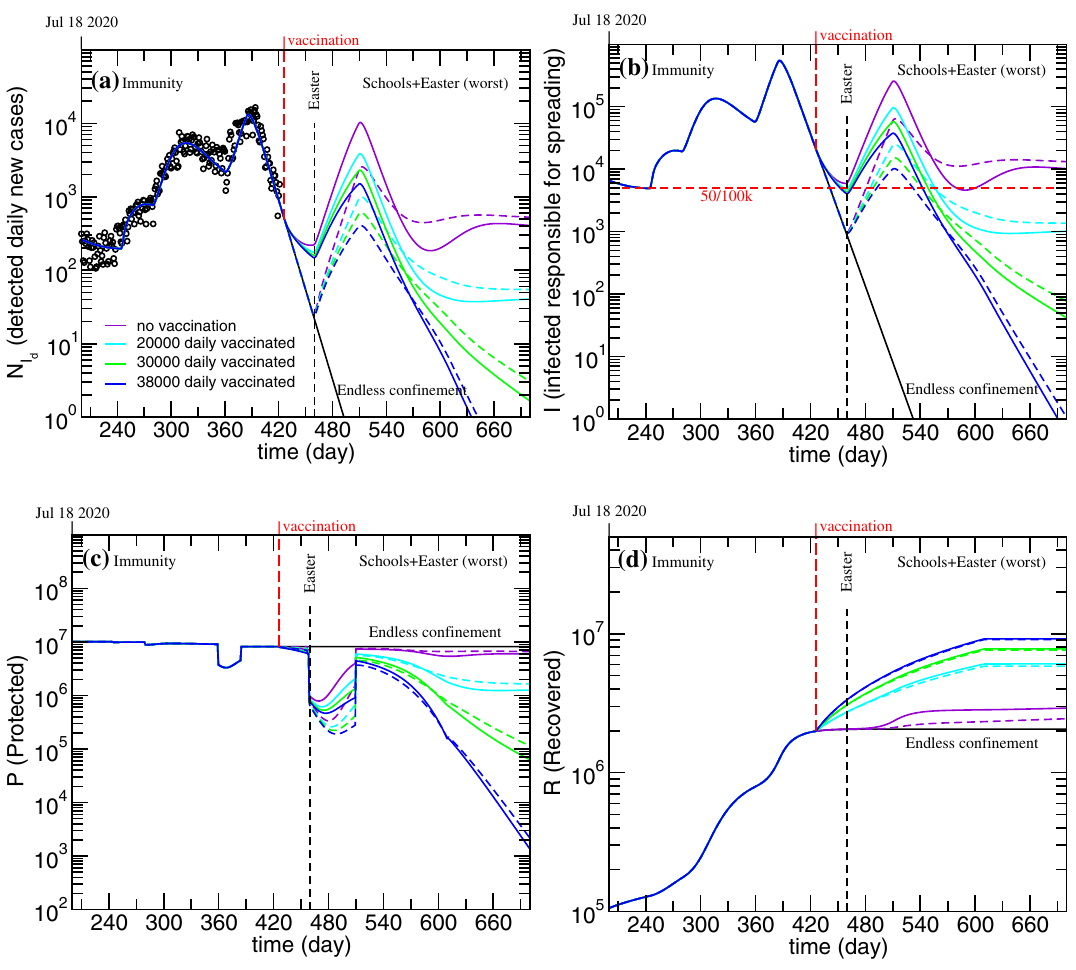
Figure 8. Evolution of the detected daily new cases ( a ), infected non-isolated, responsible for spreading the disease ( b ), protected ( c ) and Recovered ( d ). Worst case presented in Fig. 6 and the effects of different vaccination strategies considering that vaccine related immunity lasts five months. Solid lines-schools reopen on March 1; Dashed lines-schools reopen on April